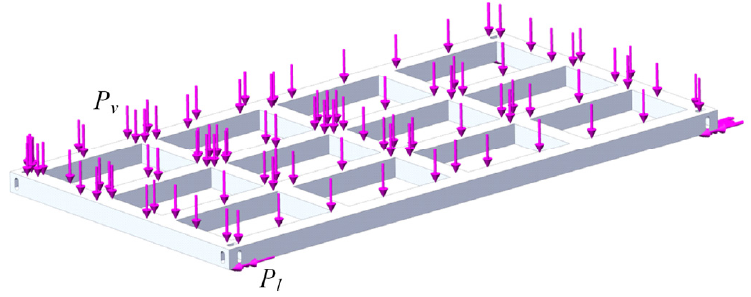
Figure 13. Design diagram of the removable module.